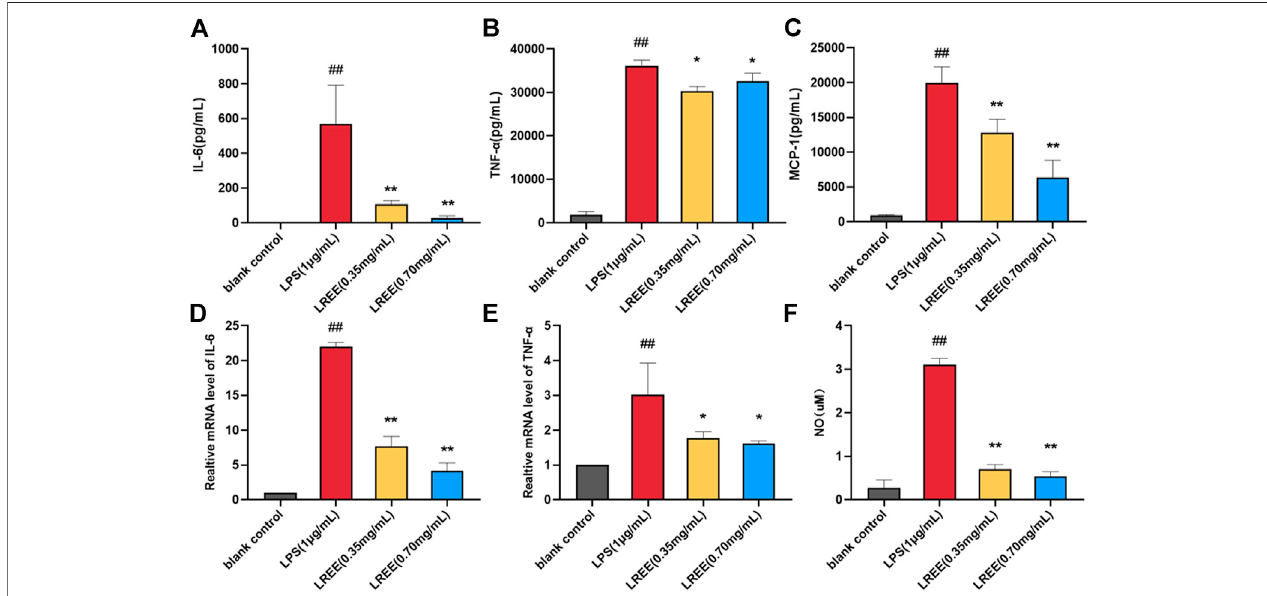
FIGURE 6 | Effects of LREE on the in fl ammatory mediators in LPS-stimulated RAW264.7 macrophages. (A – C) The protein levels of in fl ammatory cytokines and chemokine in LPS-stimulated RAW264.7 cells. (D – E) The mRNA expression levels of IL-6 and TNF- α in LPS-stimulated RAW264.7cells. (F) The expression level of NO in LPS-stimulated RAW264.7 cells. # P ＜ 0.05, ## P ＜ 0.01 versus blank control (none-LREE-treated) group. * P ＜ 0.05, ** P ＜ 0.01 vs. LPS